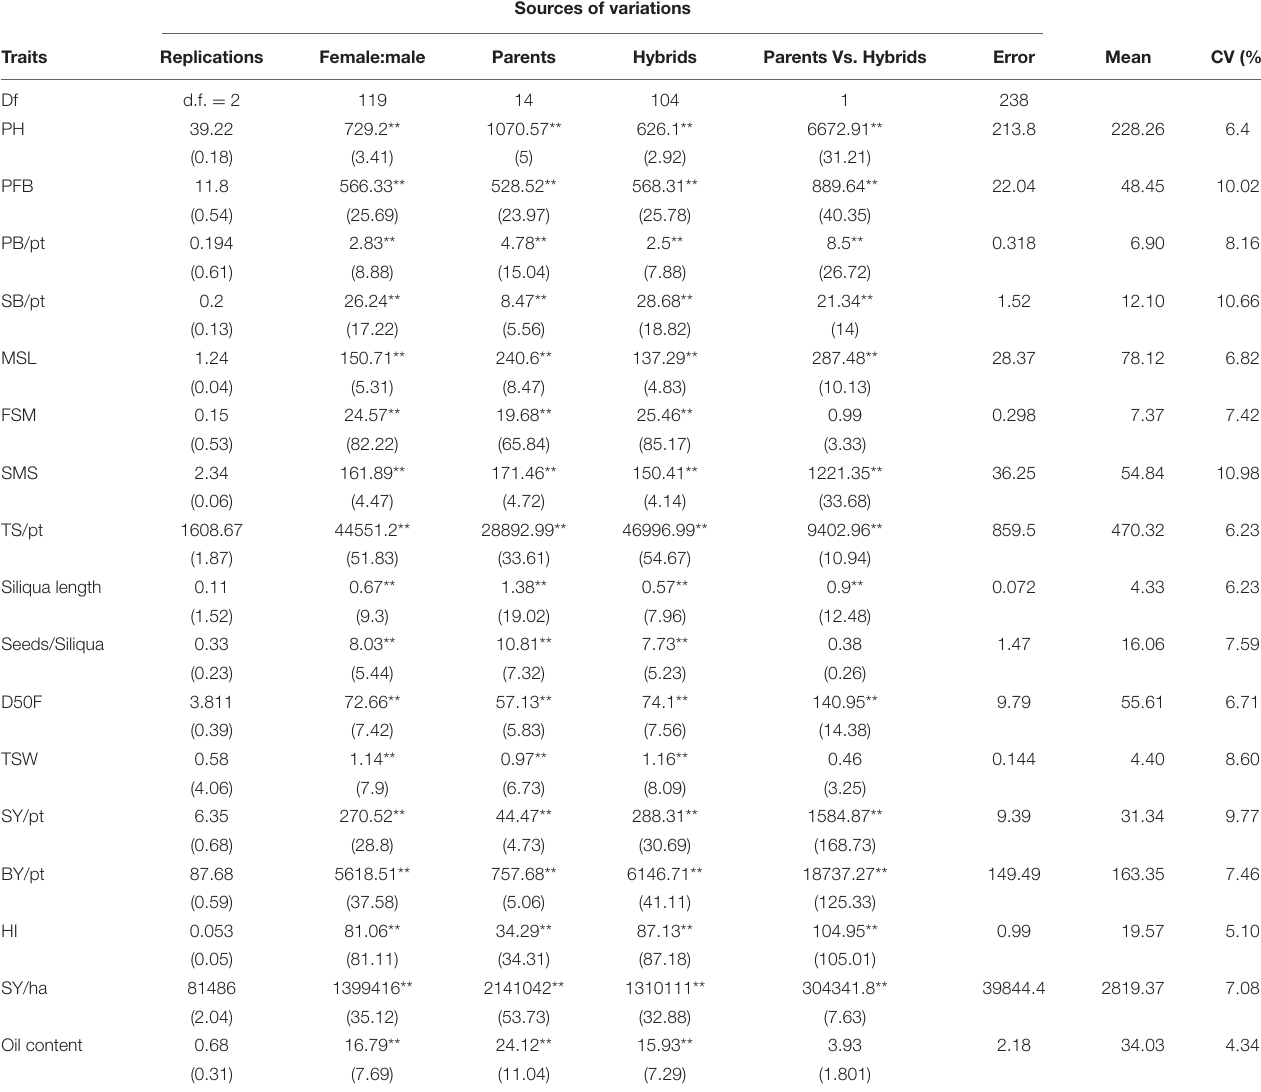
TABLE 2 | Analysis of variance for parents and hybrids generated in half diallel design for studying different yield contributing traits under rainfed conditions.